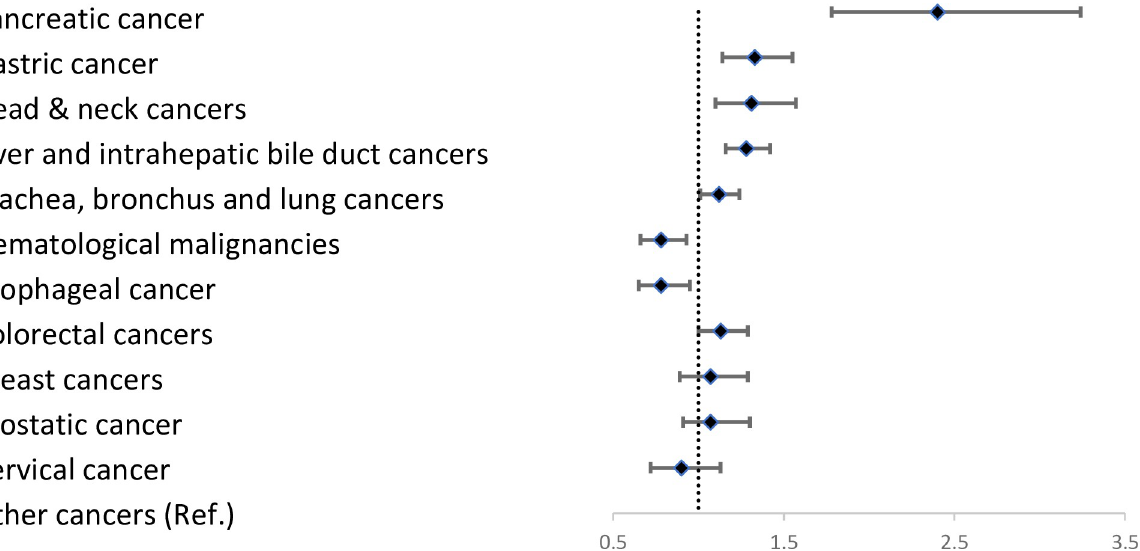
Concomitant major illnesses may affect the DNR rate. Table 2 and Fig 3 show the results of major illness combinations. Compared with patients without a major illness, cancer-only